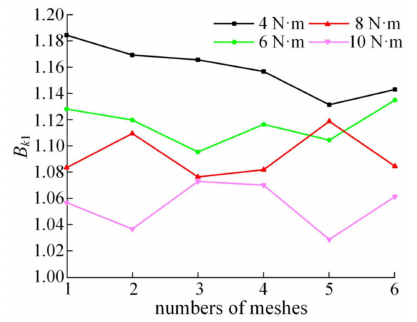
Figure 15. Load proportional coefficient curves under different loads.